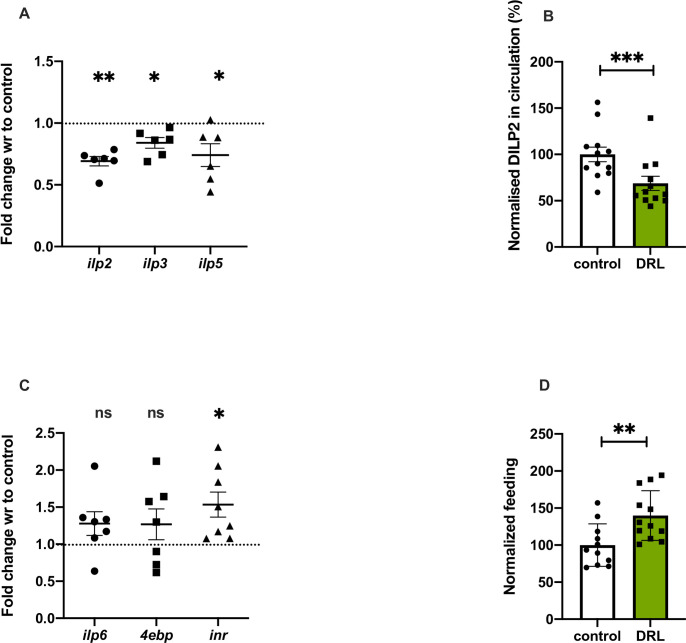
Nutrient restriction in larvae reduced insulin signalling.Nutrient restriction in larvae led to reduced insulin signalling. Shown is mRNA levels in 5-day old control and DRL flies, data are shown as fold change in mRNA levels, values are normalised to control flies and fold change in DRL flies is shown. (A) dilp2 [p-value = 0.0005], dilp3 [p-value = 0.0136] and dilp5 [p-value = 0.0375] mRNA levels from 3rd instar larvae. [independent biological replicates = 6]. (B) DILP2 levels in the hemolymph of 3rd instar DRL and control larvae. [independent biological replicates = 12; p-value = 0.0095]. (C) dilp6 [p-value = 0.1326], 4ebp [p-value = 0.2445] and inr [p-value = 0.0158] mRNA levels from 3rd instar larvae. [independent biological replicates = 6;]. All transcripts levels were normalised with rp49 mRNA (Unpaired Students t-test with Welch Correction). (D) Feeding is increased in DRL larvae compared to control larvae, data is shown as percentage feeding normalised to 100% control larvae [control n = 11; DRL n = 12, p-value <0.0058; Unpaired Students t-test with Welch Correction]. [p-value *<0.05; ** <0.01,*** <0.001, **** <0.0001, data is presented as mean ± SEM].